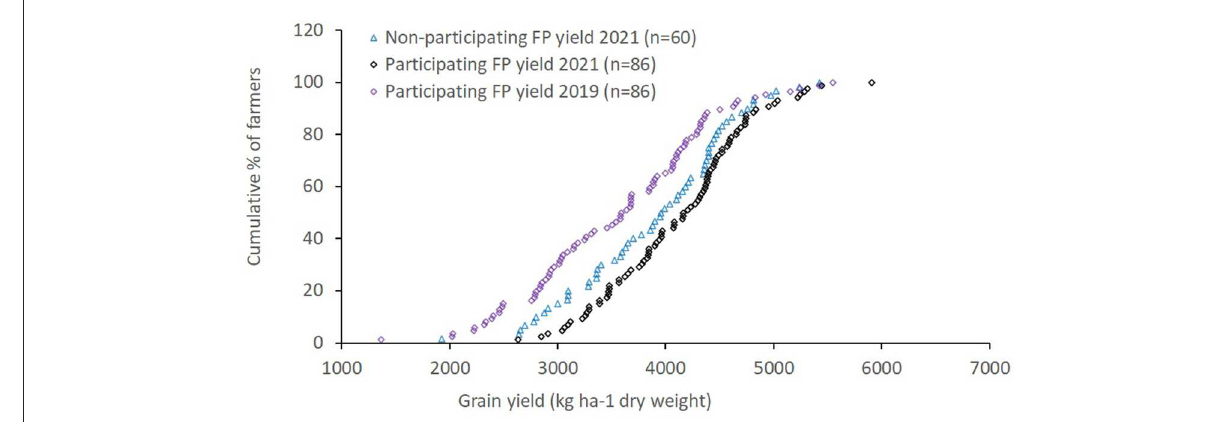
FIGURE5 Cumulative distribution of grain yield of farmers after joint experimentation in 2021. Participating farmers are those who participated and non-participating farmers did not participate in the joint experimentation.